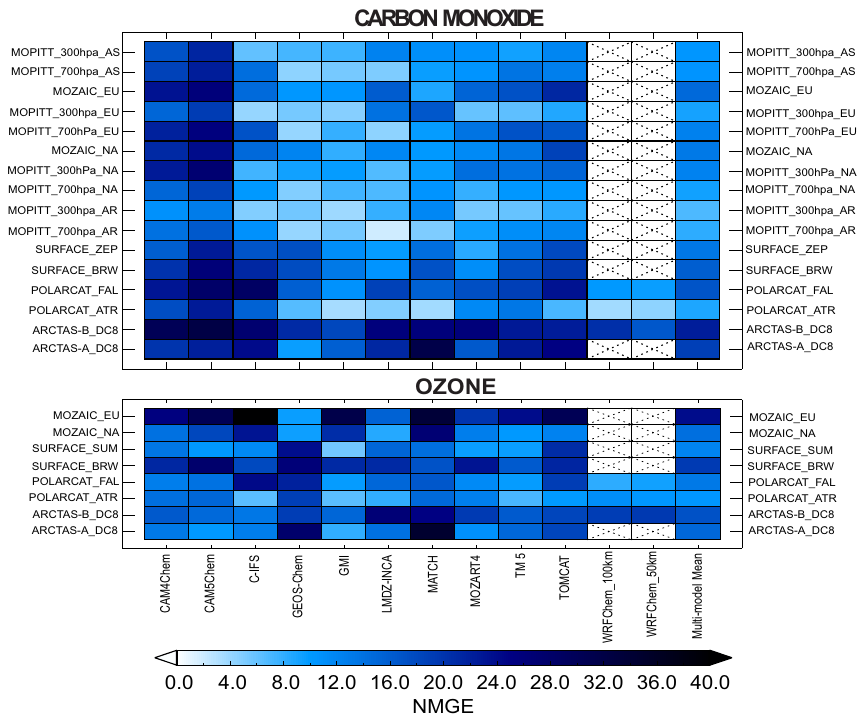
P ( | mod − obs | ) × 100) for all models against observations. The errors N obs